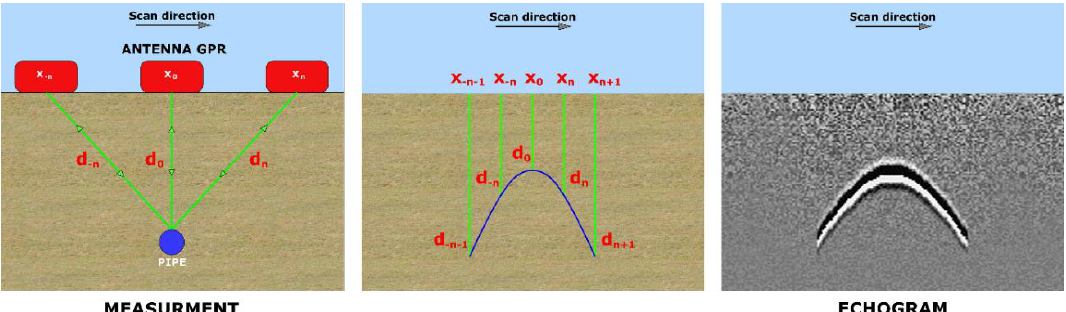
Figure 1. Shaping of buried object picture on echograms.